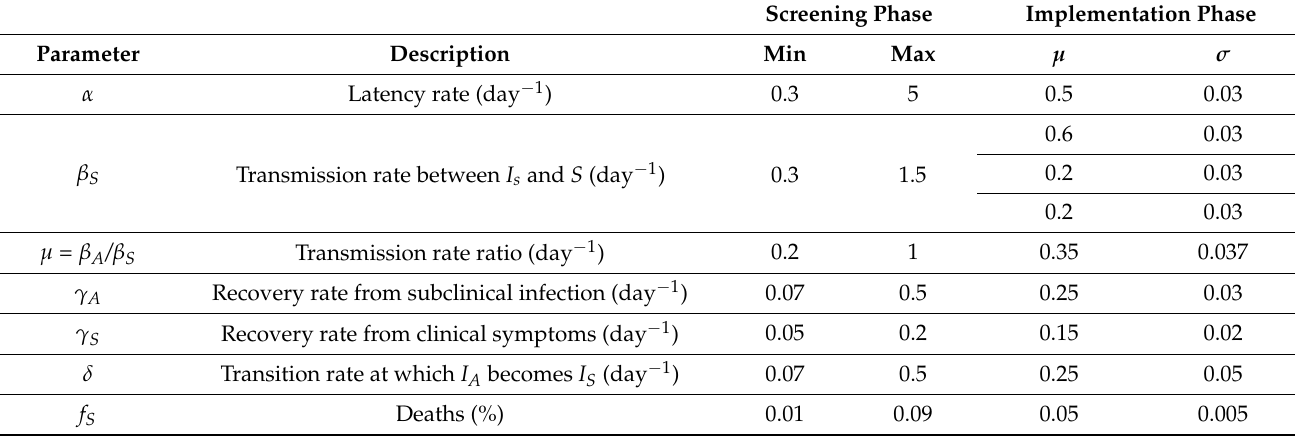
Table 1. Prior Distributions based on a uniform distribution U (min, max) during the screening phase and normal distribution N ( µ , σ ) during the implementation phase. Transmission rate ( β S ) values refer to those before, during and after the intervention